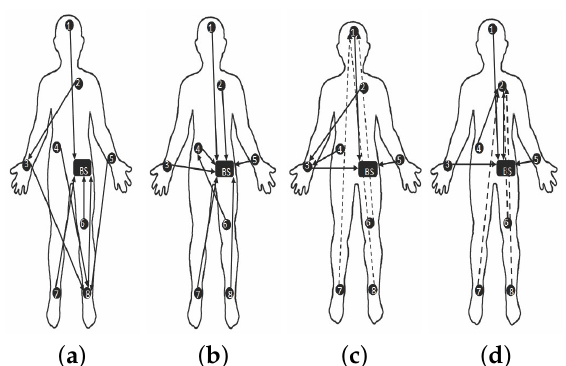
Figure 11. Typical network topology while walking activity. ( a ) At TX 1 ; ( b ) At TX 2 ; ( c ) At TX 3 ; ( d ) At TX 4